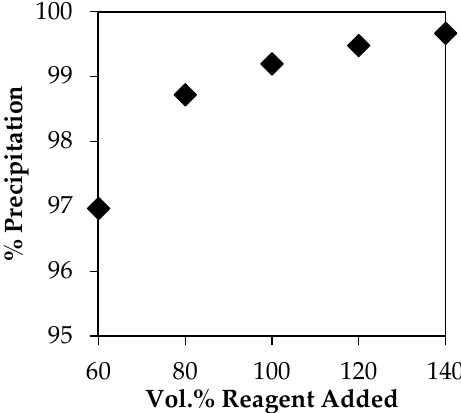
Figure 3. Effect of ethanol addition at higher ratios (Adopted from [37]).